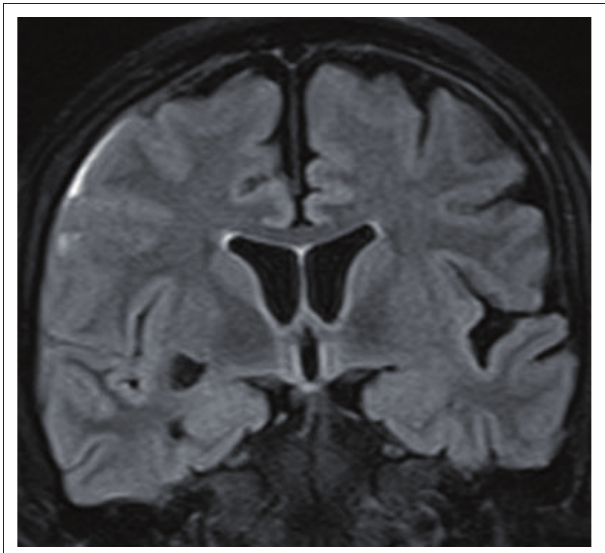
FIGURE 4: Coronal flair MRI image.